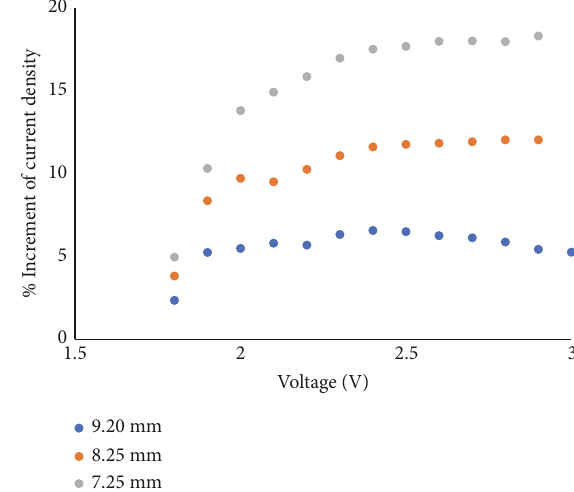
Figure 3: Percentage increment of current density analysed from the farthest distance between electrodes